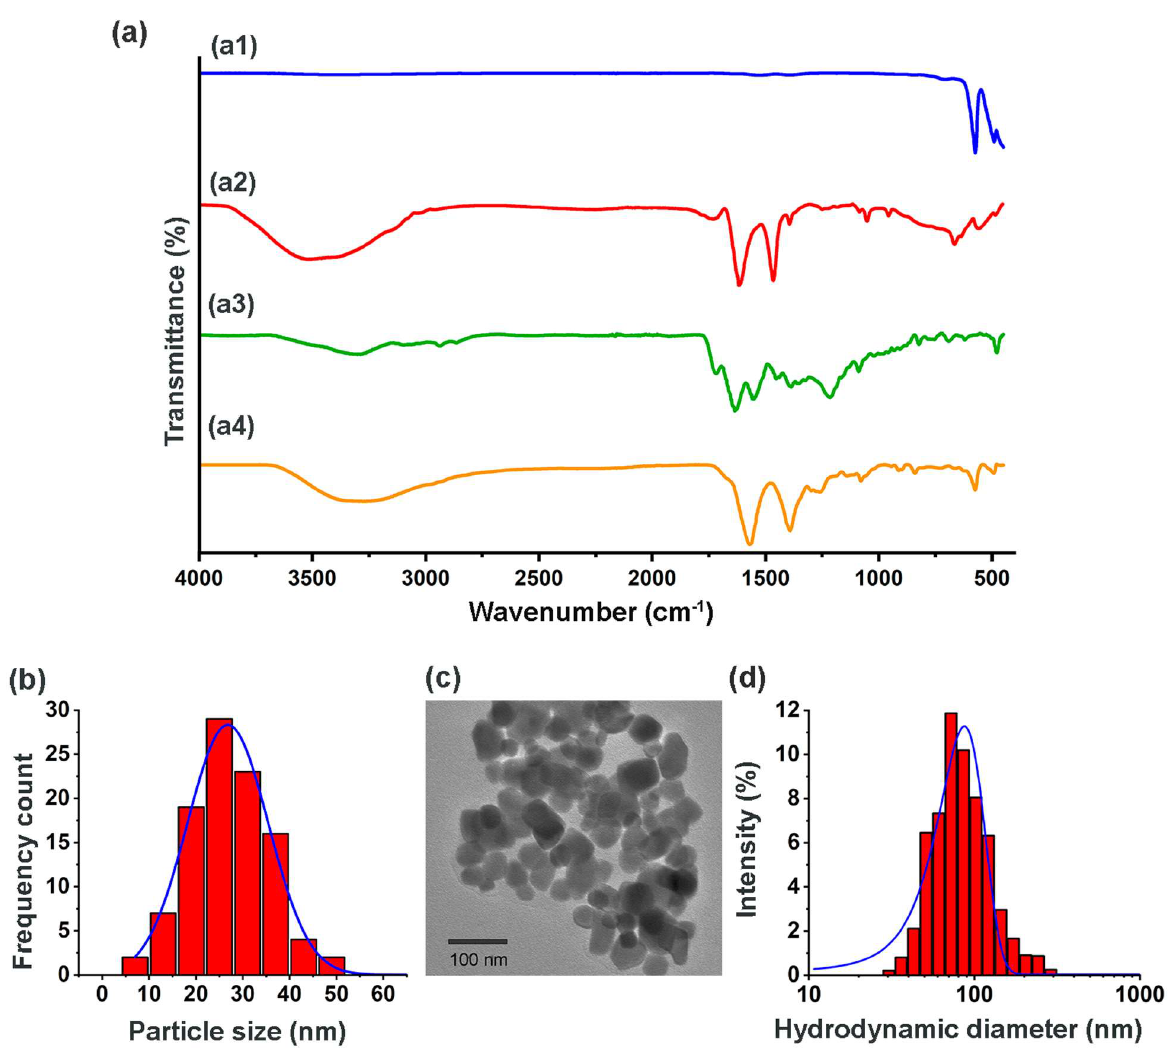
Figure 1. Chemical characterization of [ 177 Lu]Lu − iFAP/iPSMA nanoparticles formulated under GMP conditions (evaluation after the complete decay of 177 Lu). ( a ) Infrared spectra: (a1) Lu 2 O 3 nanoparticles, (a2) iFAP, (a3) iPSMA, and (a4) Lu−iFAP/iPSMA; ( b ) size distribution of Lu−iFAP/iPSMA by TEM; ( c ) TEM micrograph of Lu−iFAP/iPSMA; ( d ) size distribution of Lu−iFAP/iPSMA by DLS (hydrodynamic diameter: particle diffusion within the fluid).